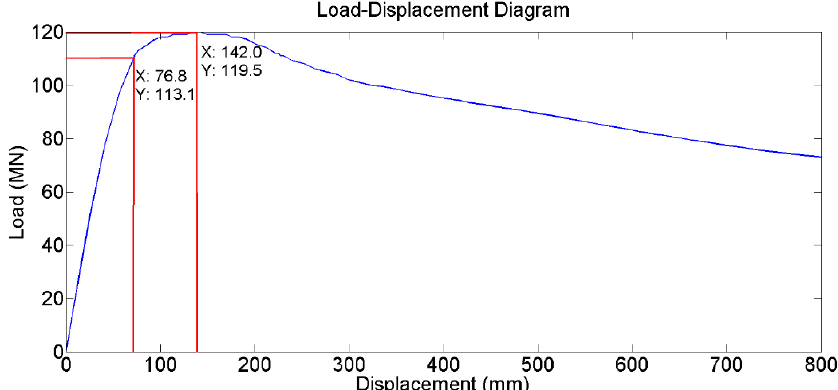
Figure 5. A load-displacement diagram (of the JX-structure) showing the example of the maximum load with the corresponding vertical displacement on the top of the structure (119.5 MN, 142.0 mm) and the critical load with the corresponding vertical displacement (113.1 MN, 76.8 mm) defined for a full-scale model.